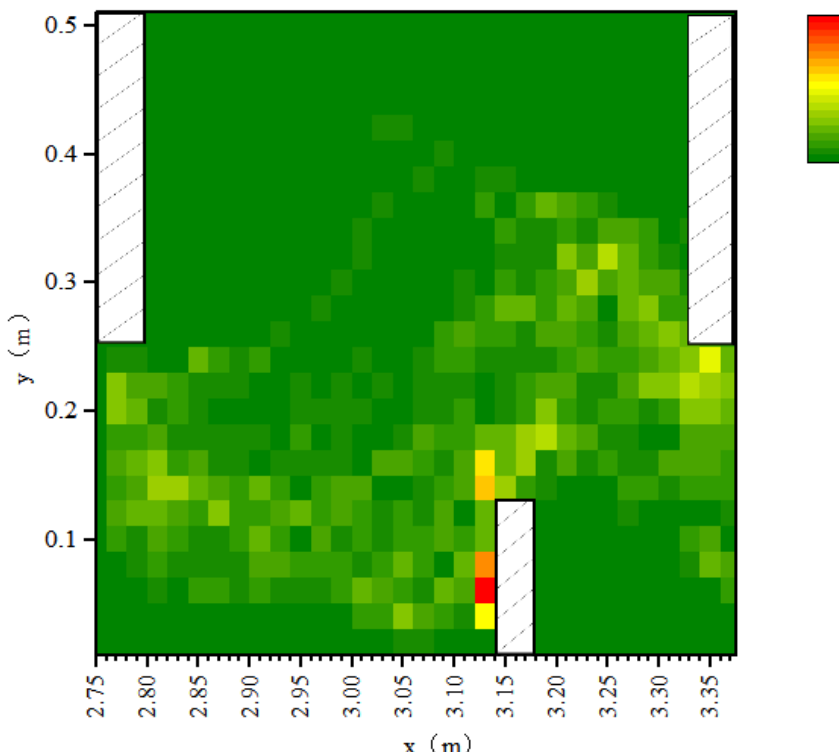
Figure 4. Heat maps of the fish occurrence number and movement trajectories with Q = 13.5 L/s. Note: the x -axis represents the coordinate value of pool 3 along the x direction, the y -axis represents the coordinate value of pool 3 along the y direction.